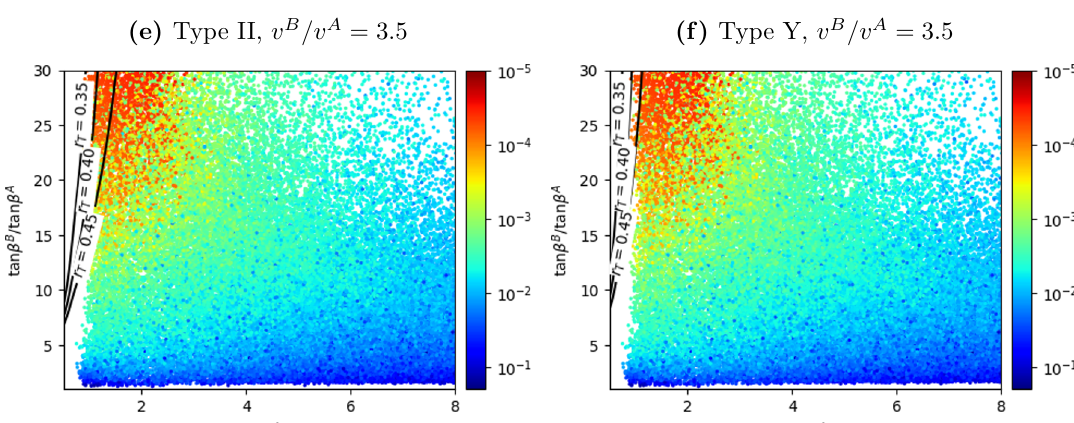
and T (cid:18) . 1 2